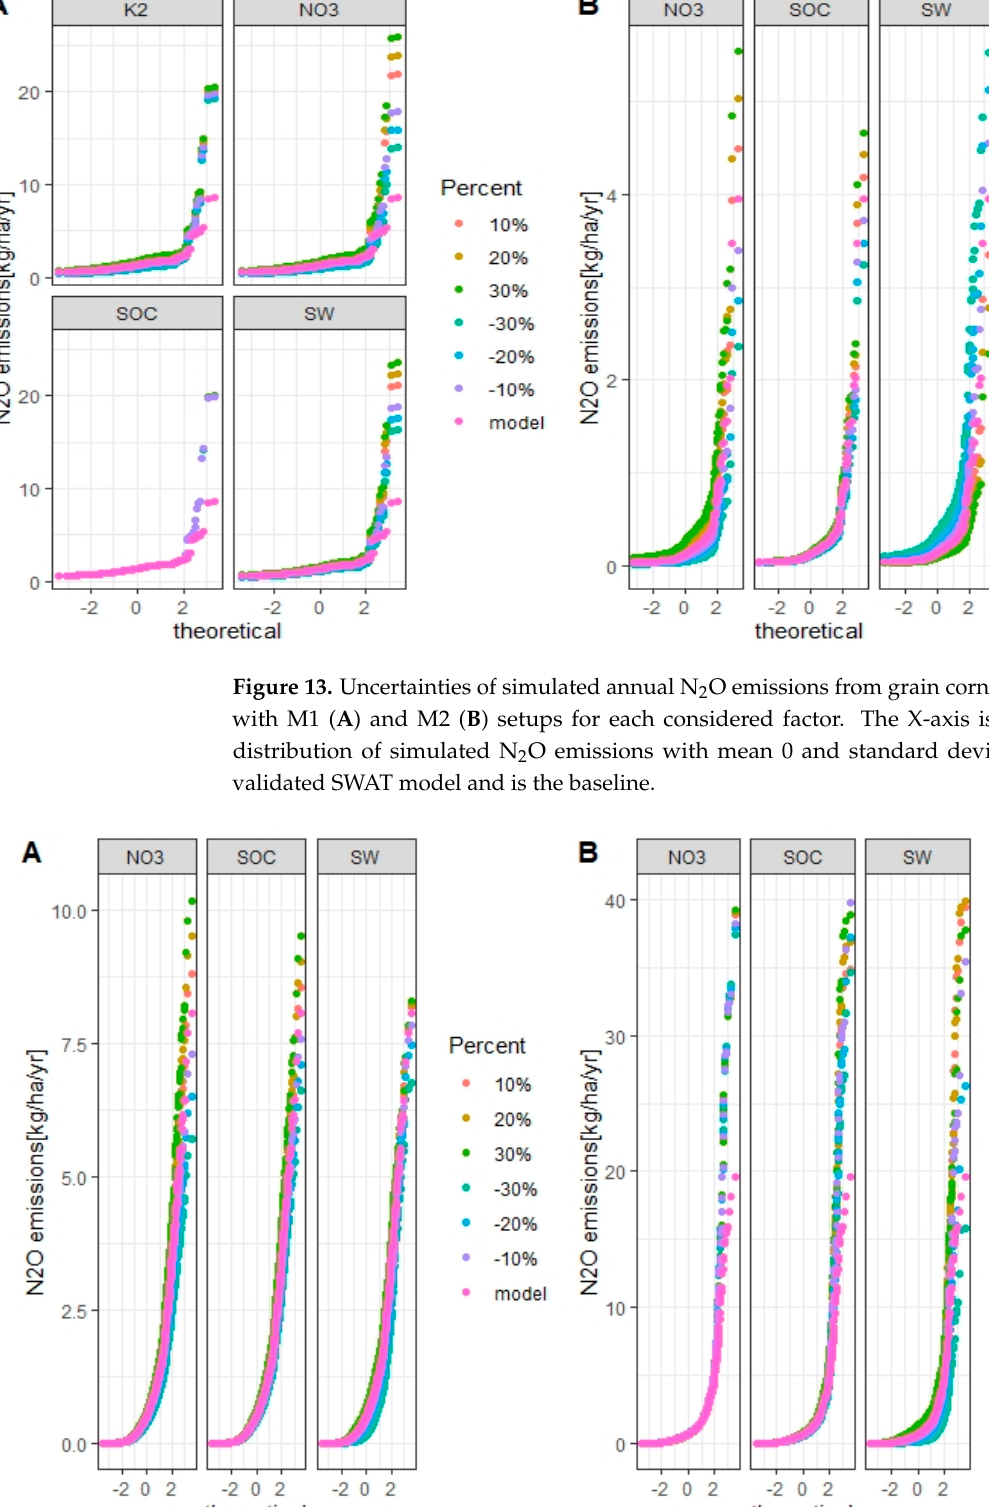
Figure 12. Uncertainties of simulated annual N 2 O emissions from winter wheat in the Melk catch- ment with M1 ( A ) and M2 ( B ) setups for each considered factor. The X-axis is the standard normal distribution of simulated N 2 O emissions with mean 0 and standard deviation 1. Model is the vali- dated SWAT model and is the baseline.